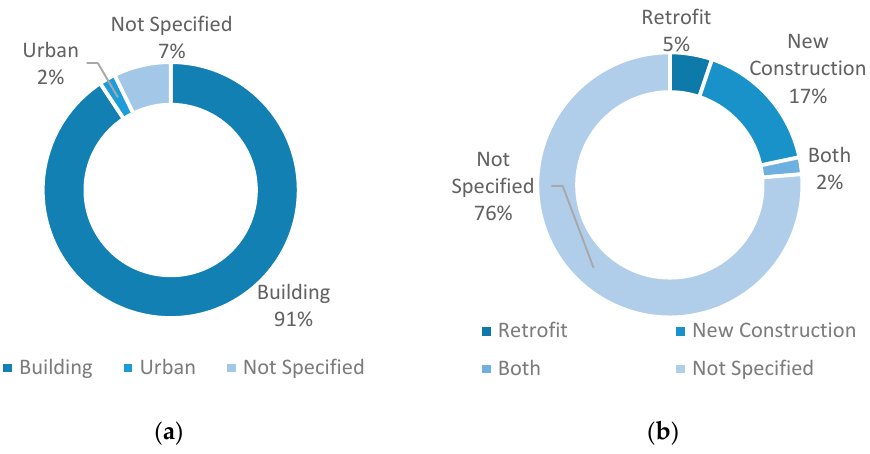
Figure 3. Scale ( a ) and building construction type ( b ) of 117 ADBE publications between 2006 and